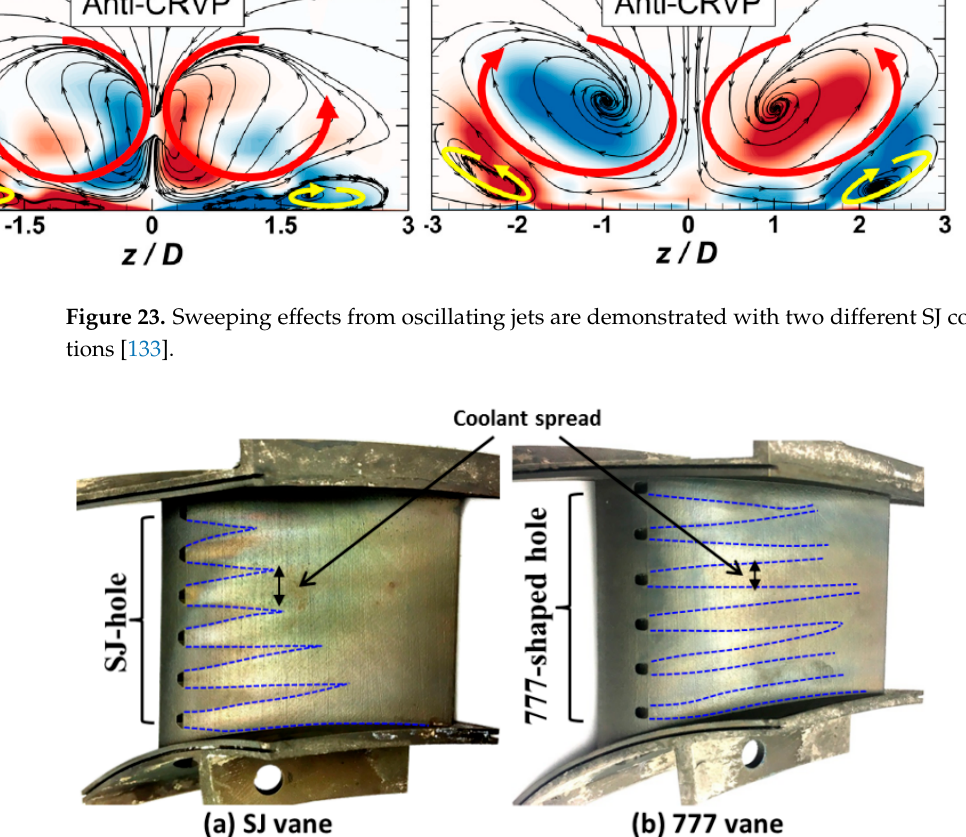
Figure 23. Sweeping effects from oscillating jets are demonstrated with two different SJ configura- tions [133].